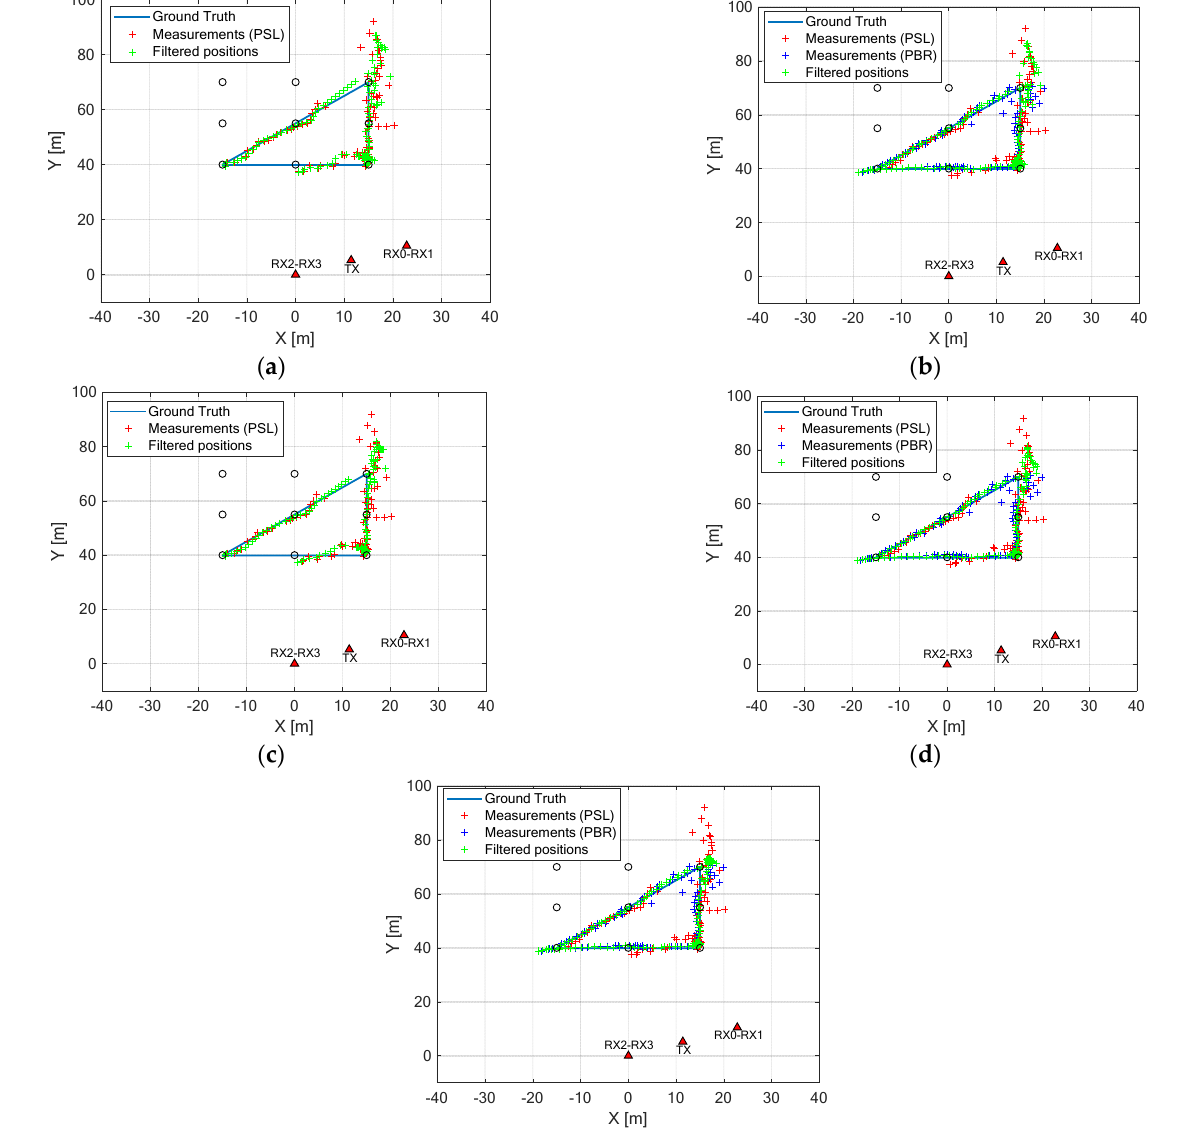
Figure 14. The localization and tracking of human targets on the x-y plane with: ( a ) the KF-NCV (Single Sensor), ( b ) KF-NCV (Sensor Fusion), ( c ) IMM (Single Sensor), ( d ) IMM (Sensor Fusion) and ( e ) IMM-MI (Sensor Fusion).